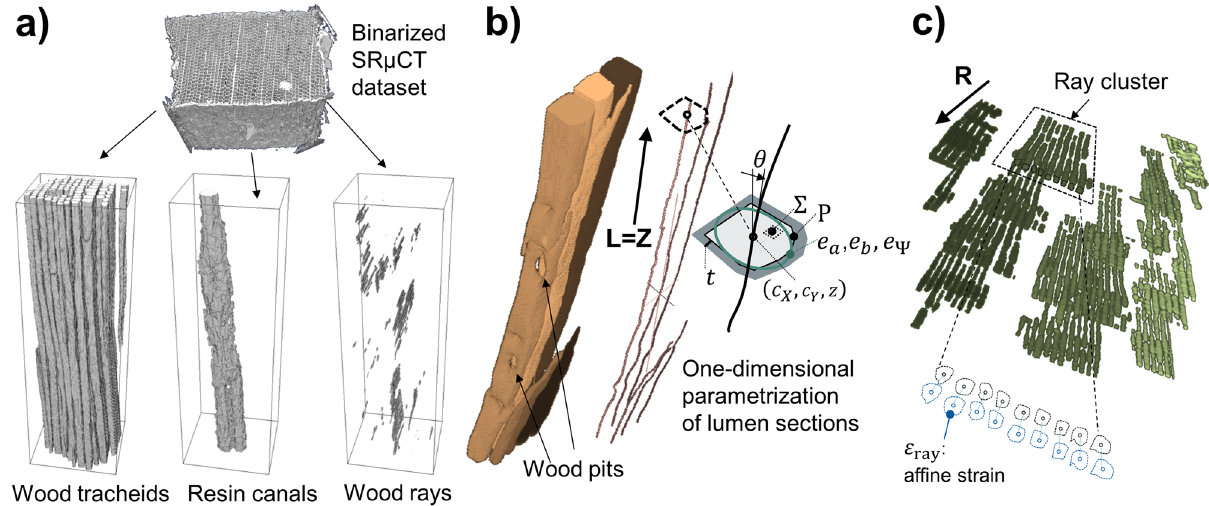
Figure 2. ( a ) Segmentation of wood tracheids, wood cells, and resin canals from SRμCT. The segmentation is performed based on the binarization and morphological analysis of the cell lumens -air voids- which provide approximately closed tubular geometries. ( b ) High-resolution renders of wood tracheids. The split cell structure visualizes in different colors the cell lumens of each tracheid. The tubular cell structure allows one-dimensional parametrization of tracheid lumen cross-sections along the grain direction L. The cell wall thickness t is determined from the skeletonization of cell wall substance with respect to the adjacent tracheid cell lumens. Wood pits are preserved during the segmentation process as landmarks for deformation tracking. ( c ) One-dimensional parametrization of wood rays along the radial direction R, including clustering of lumens belonging to the same wood ray. The ray lumen parameterization procedure along R is analogue to the parameterization of tracheid cells along